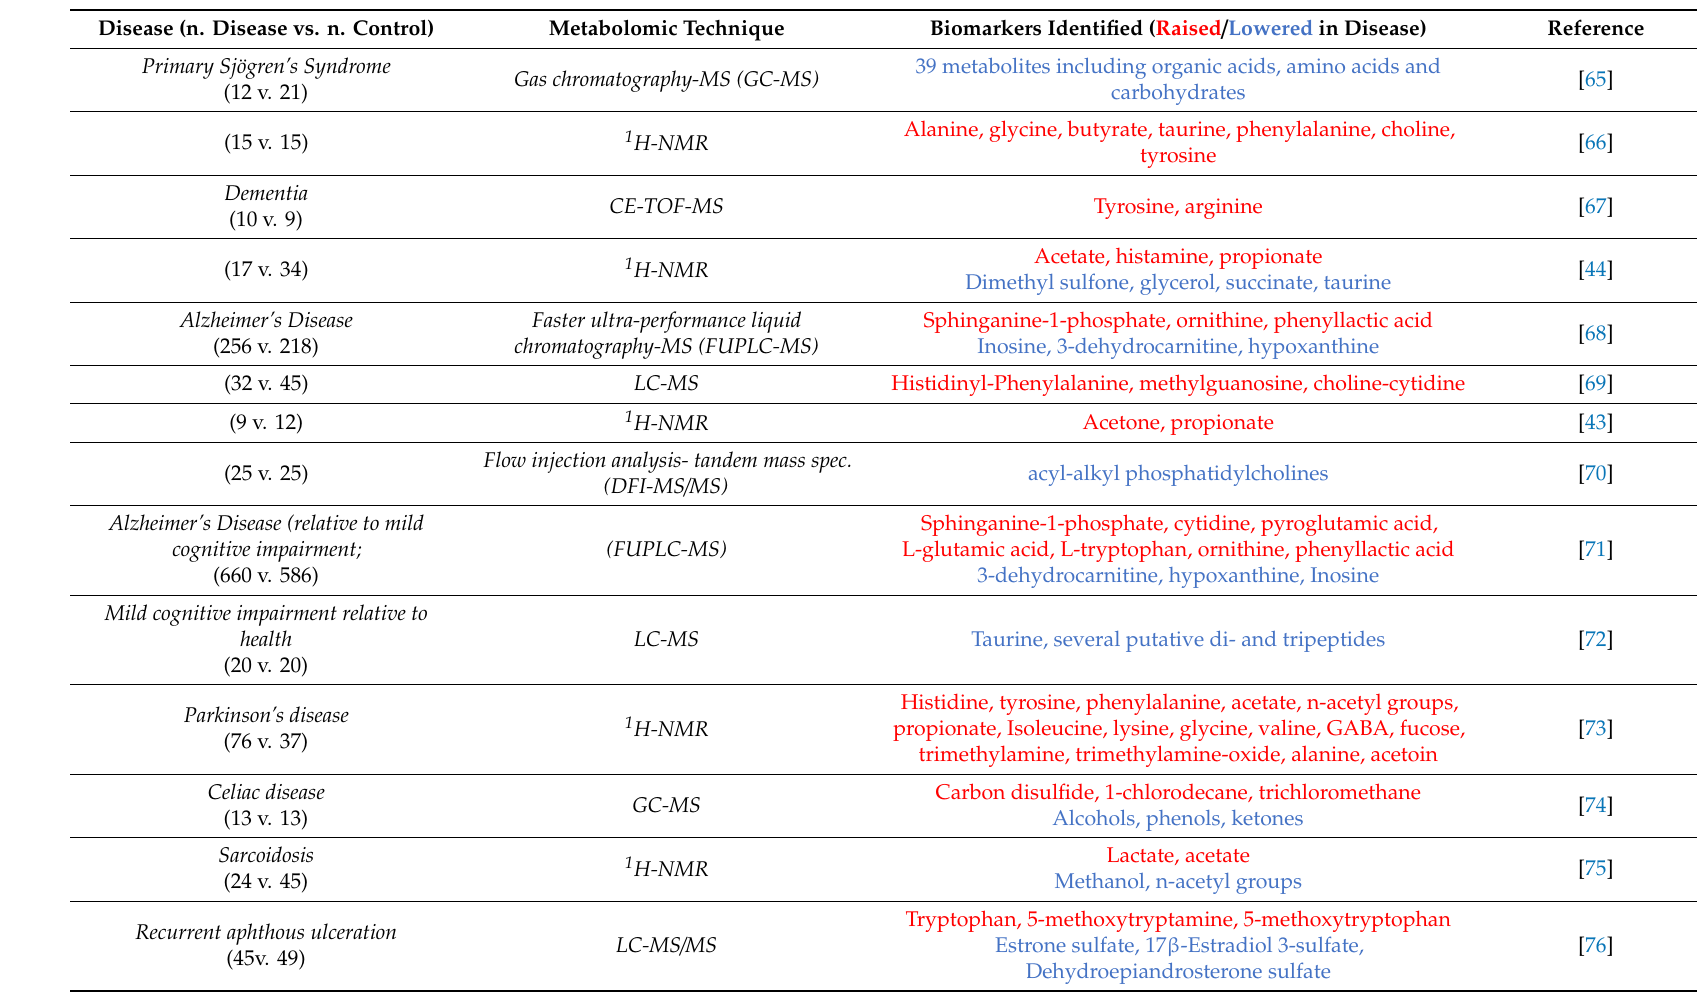
Disease (n. Disease vs. n.